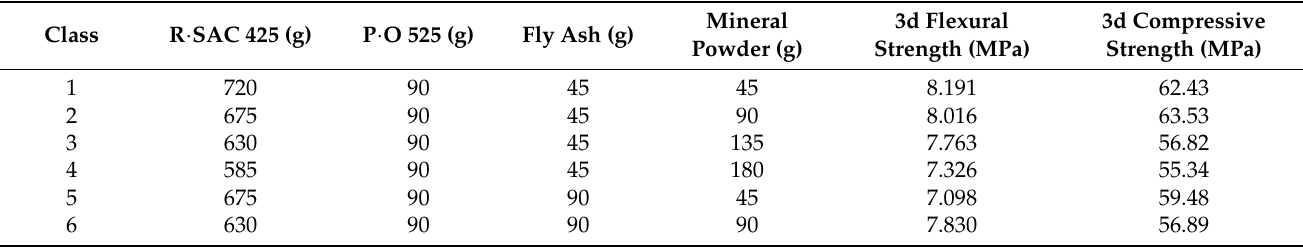
Table 6. Results of 3d strength test of grouting materials with different amount of cementitious